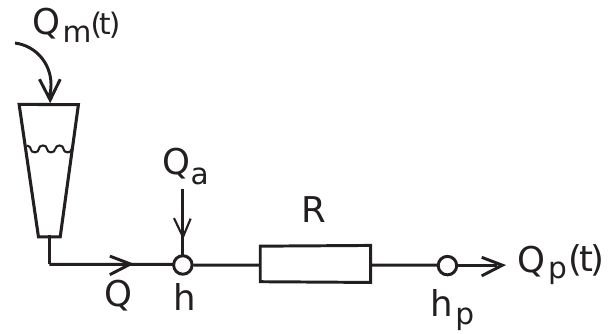
Table 1. Physical